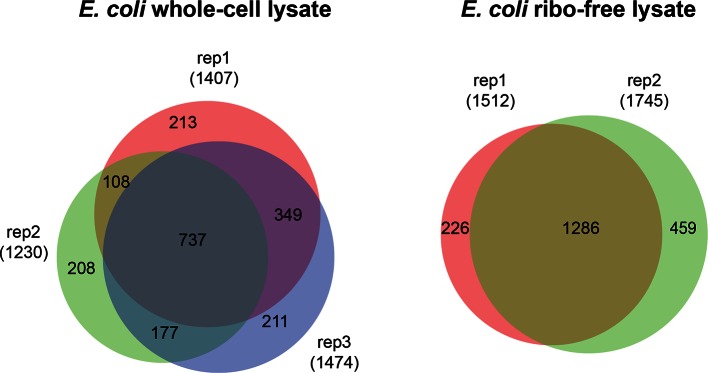
Overlap of cross-linked lysine pairs between biological replicates of E. coli lysates (FDR < 0.05, E-value < 0.01, and spectral count ≥ 3).